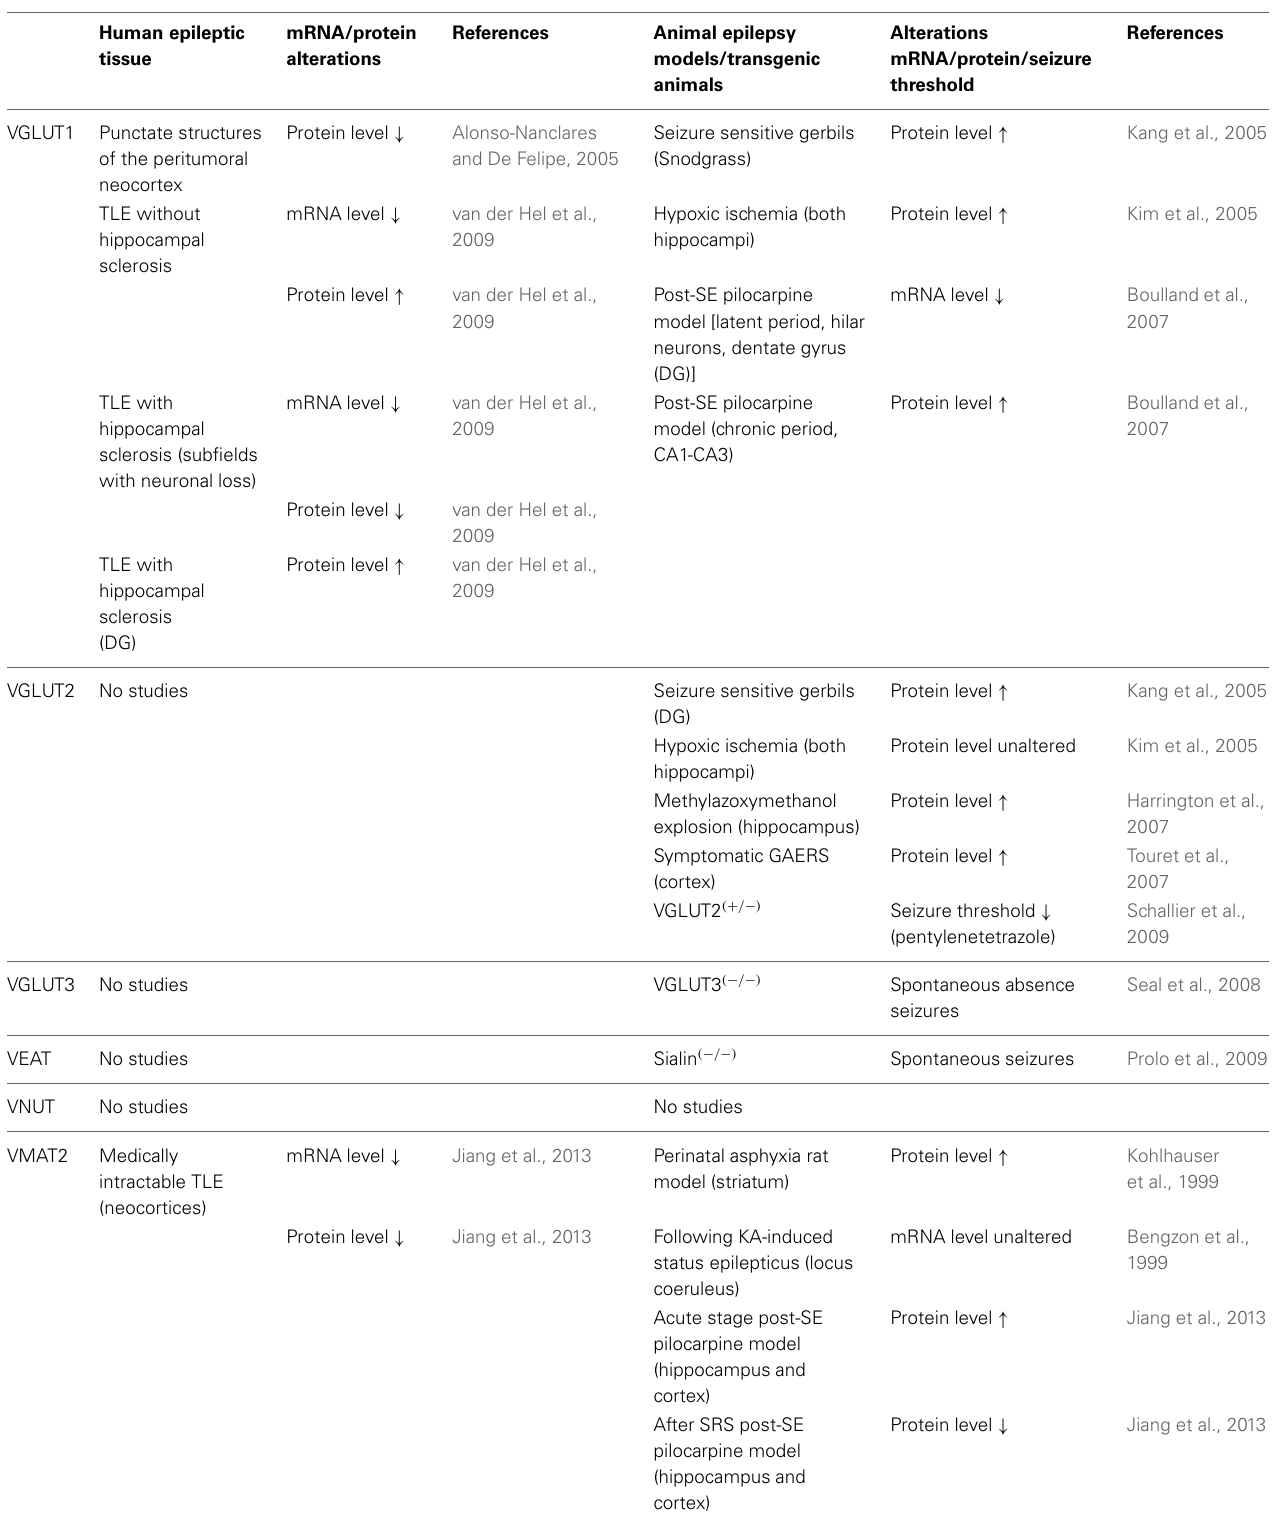
Table 1 | Summary of literature regarding transgenic mice with disruptions in vesicular nucleotide transporters (VNTs) in different models of seizures and epilepsy, as well as the known alterations and reorganizations in the expression levels of these VNTs in rodent models for temporal lobe epilepsy (TLE) and in human tissue resected for epilepsy